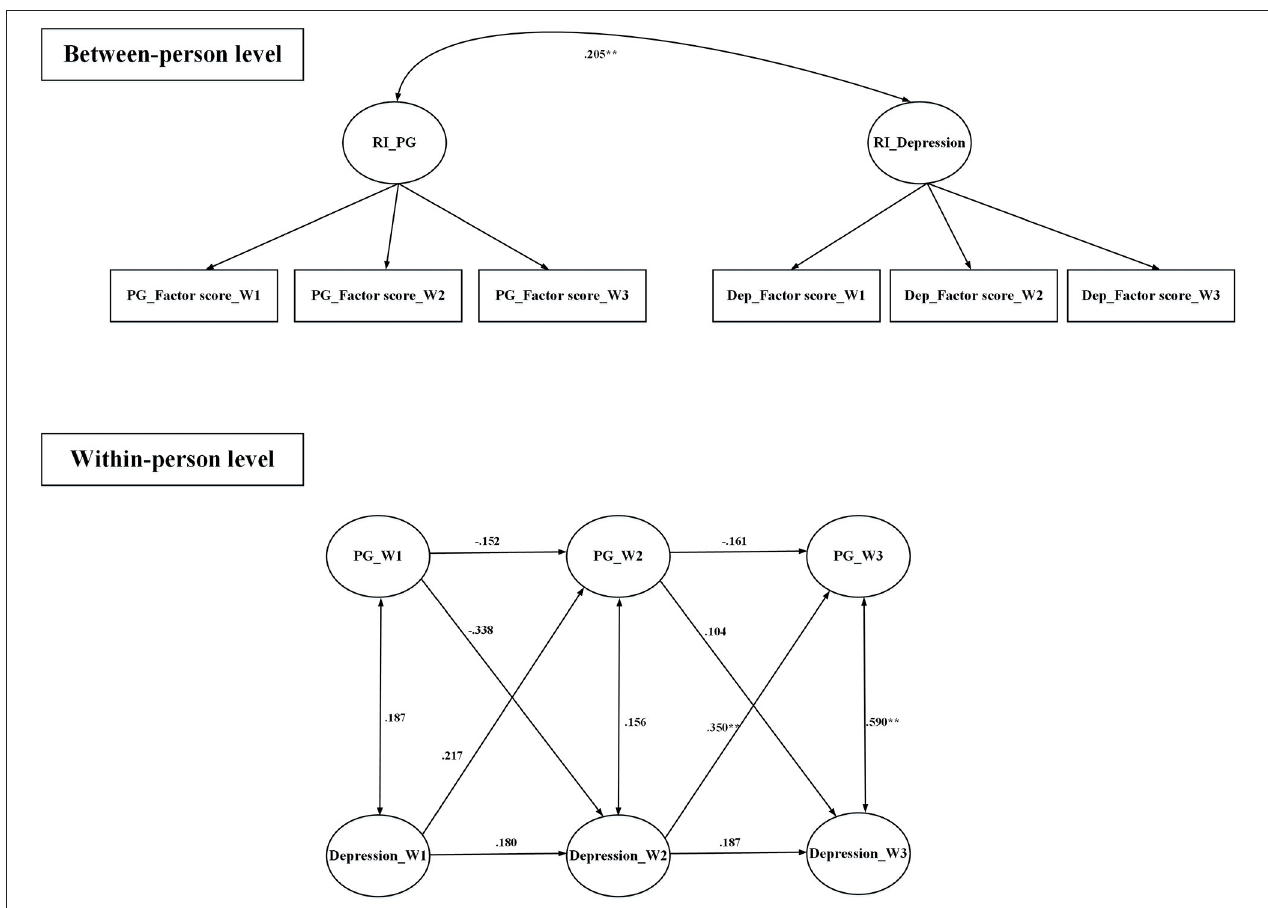
FIGURE 4 | Cross-lagged model of PG and depression using lagged bidirectional model. Covariates include gender and age. Depression was assessed using the Hospital Anxiety and Depression Scale; PG, problematic gaming was assessed using the Internet Gaming Disorder Scale-Short Form. RI, random intercept; W1, wave 1; W2, wave 2; W3, wave 3. All the estimates are standardized coefficients. * p < 0.05; ** p <